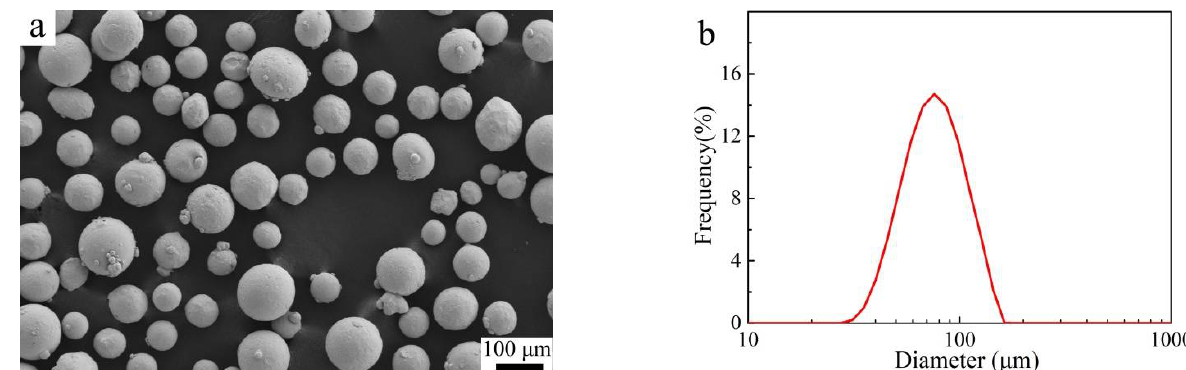
Figure 1. ( a ) SEM morphology and ( b ) particle size distribution of the as-received powders.